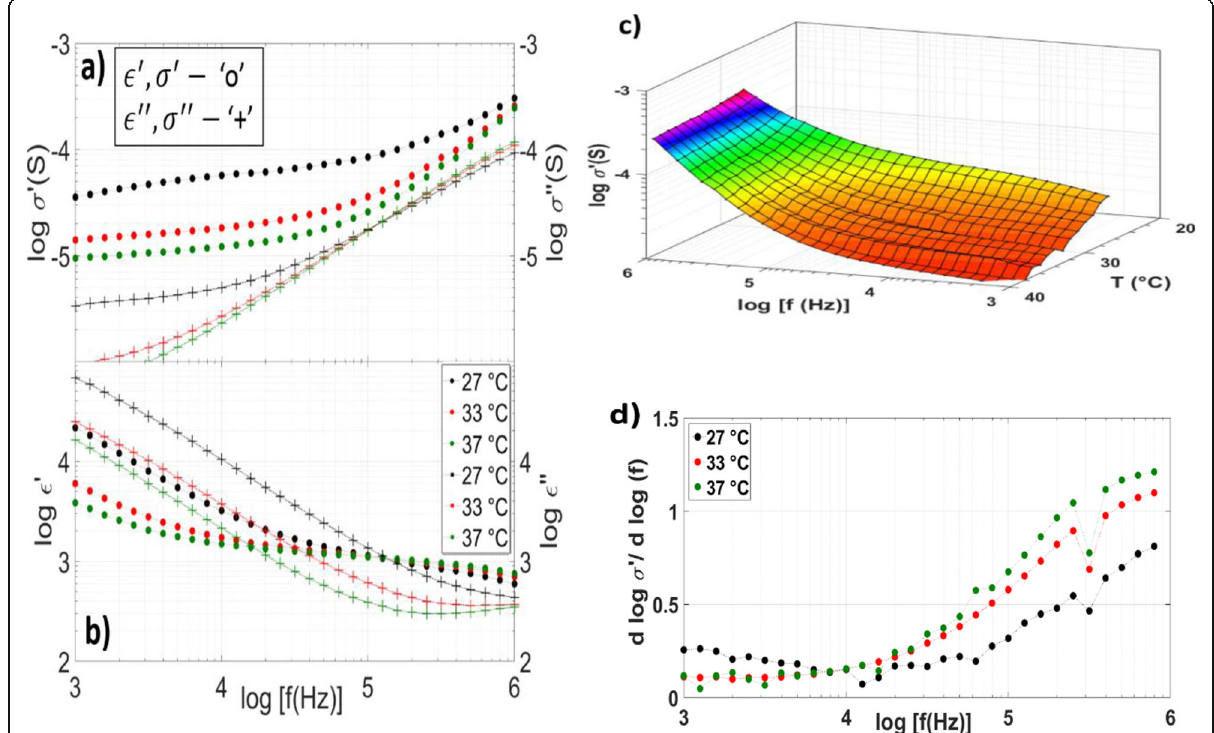
Fig. 2 PVA-PNIPAm temperature-dependent spectroscopy. Real and imaginary conductivity ( a , top left), dielectric constant ( b , bottom left) at 27 °C (black), 33 °C (red), and 37 °C (green) for PVA+ PNIPAm formed using free radical polymerization. c (top right) The temperature (T) – dependent conductivity σ ′ ( f , T ) is passivated as compared with bulk PNIPAm, but still shows increased MWS with temperature. (d, bottom right) d (log σ ′ )/d log (f) at 27 °C (black), 33 °C (red), and 37 °C (green) showing the extent of MWS polarization in the sample shifted to a higher frequency as compared with bulk PNIPAm due to decreased particle